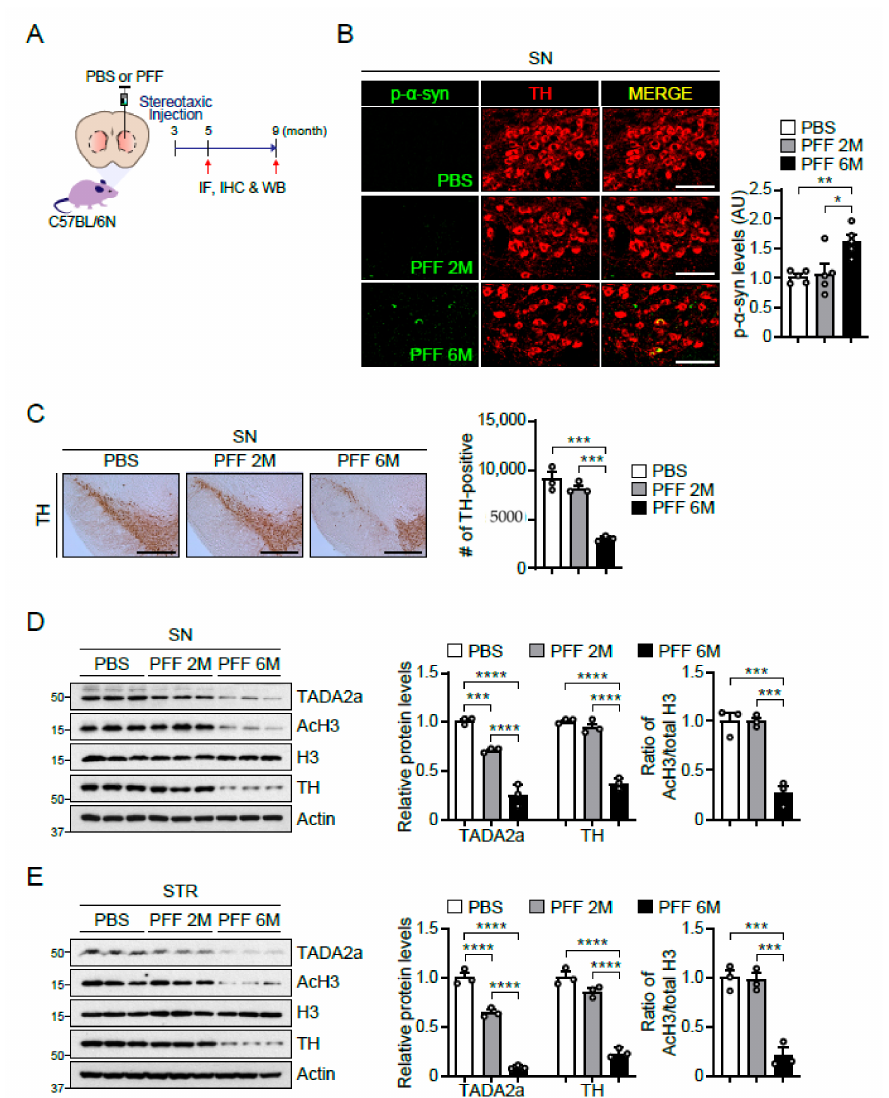
Figure 5. Reduction in TADA2a levels and histone H3 acetylation in intrastriatally α -syn PFF-injected mice. ( A ) Experimental scheme for generating α -syn PFF-injected mice. α -Syn PFF-injected mice were sacrificed for immunofluorescence (IF), immunohistochemistry (IHC), and immunoblot analysis (WB) at 2 and 6 months after injection. ( B ) Representative images of phosphorylated α -syn (p- α -syn, green) and TH (red) immunofluorescence in the SN of PBS- and α -syn PFF-injected mice (2 and 6 months post-injection; 2M and 6M). Scale bars = 100 µ m. Quantification of p- α -syn immunofluorescence in the SN of indicated mouse groups, n = 5 per group (right panel). ( C ) Representative images of immunohistochemistry of TH in the SN of PBS- and α -syn PFF-injected mice. Scale bars = 500 µ